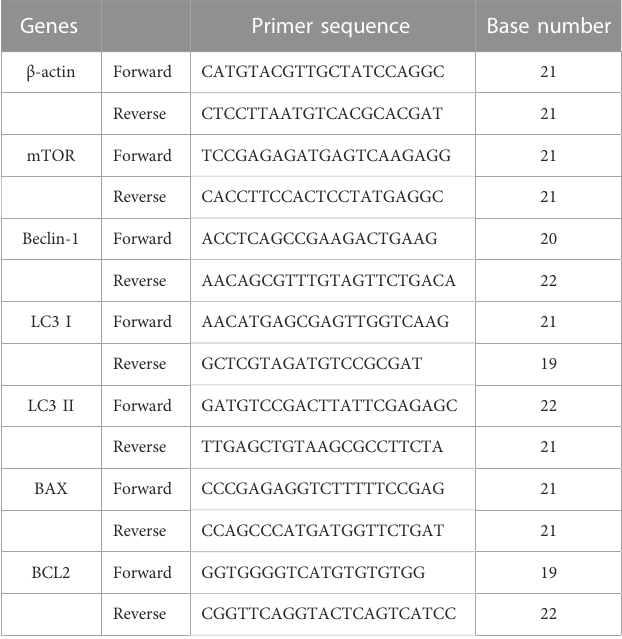
TABLE2Forwardandreverseprimersof β -actin,mTOR,Beclin-1,LC3I,LC3II,BAX and BCL2 for qRT-PCR